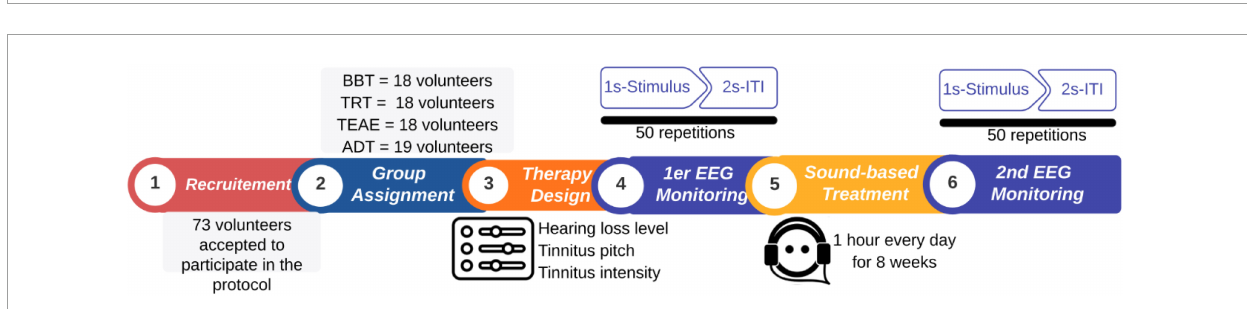
FIGURE5 Organization of the experimental procedure. In total, 71 patients voluntarily participated in the present study. Patients followed up an 8 week sound-based program. An EEG monitoring was undertaken before and after the program to evaluate the effectiveness of acoustic therapy in use.